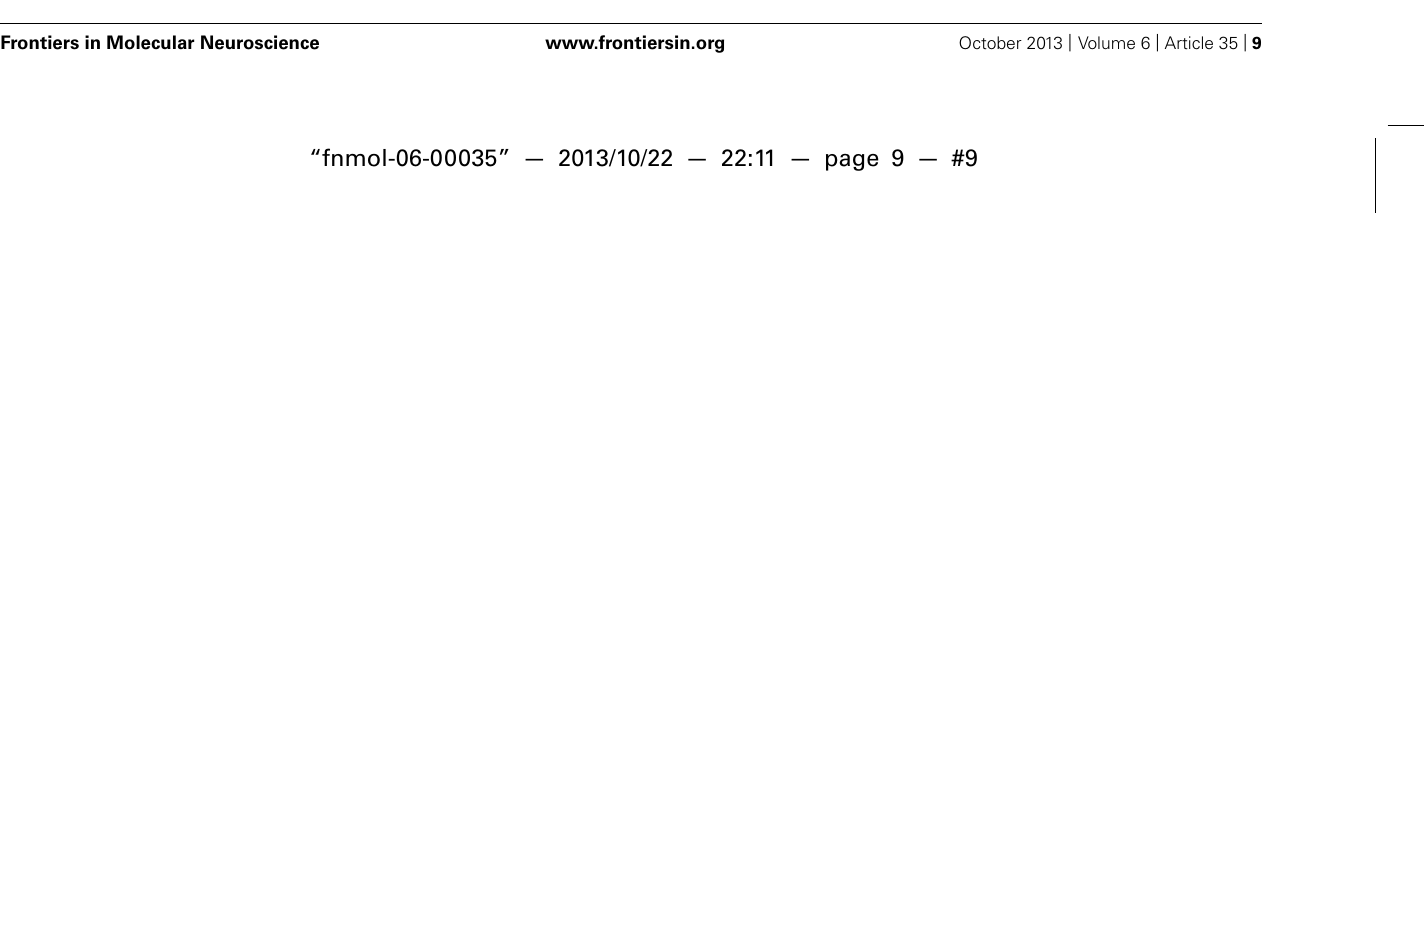
(C) Immunofluorescent staining in dissociated DRG neurons demonstrated the expression of Kremen1 within neurons. Kremen1 as a transmembrane receptor was shown to be located in cell bodies, but not axons.TUJ staining was used to visualize neuronal cells. Preconditioning of sciatic nerve clearly promotes regenerative axon growth in DRG neurons, and this phenomenon is accompanied by a decrease in Kremen1 expression. Scale bar: 20 μ m. (** p < 0.01) For the analysis of two independent groups, Student’s t -test was